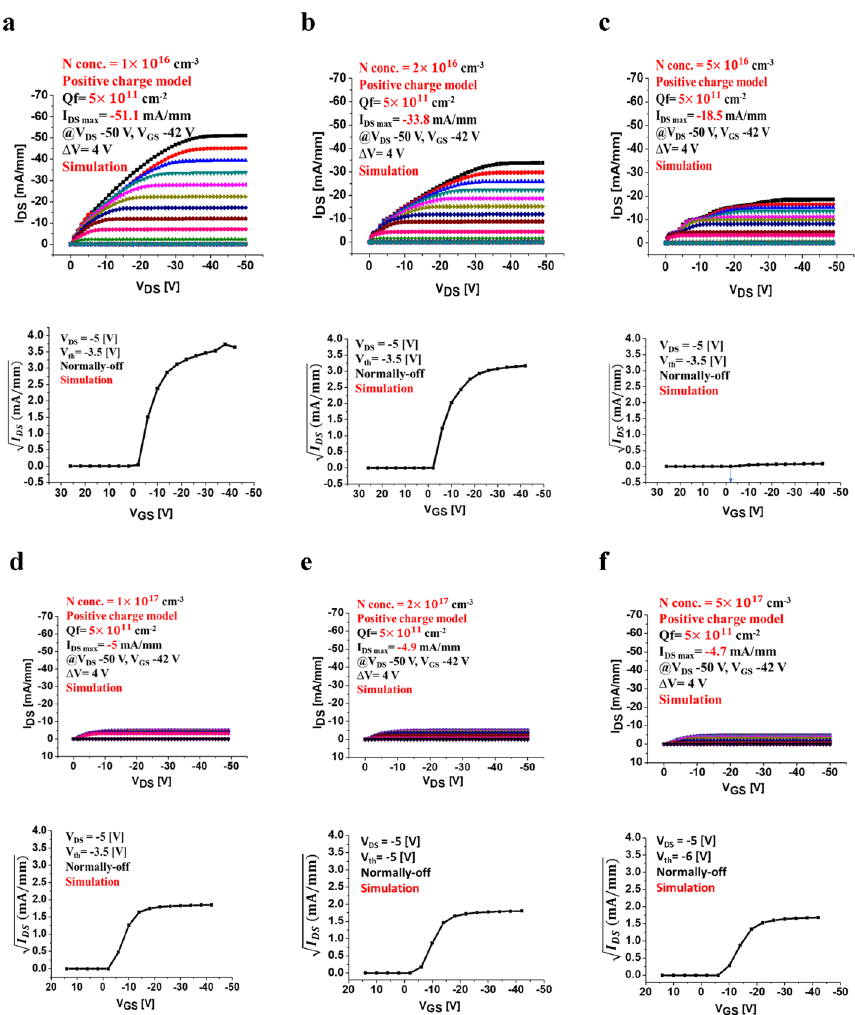
Figure 3. The theoretical modeling and output characteristics of 2DHG diamond MOSFET positive surface charge sheet model (simulation) of 5 × 10 11 cm -2 with a boron doping concentration of 4 × 10 15 cm -3 and various nitrogen doping layer at the room temperature. (a) The maximum drain current density is simulated at I DS Max = − 52 mA/mm with nitrogen concentration of 1 × 10 16 cm -3 and the V th is at − 3 eV. (b) I DS Max = − 33 mA/ mm with nitrogen concentration of 2 × 10 16 cm -3 and the V th is at − 3 eV. (c) I DS Max = − 19 mA/mm with nitrogen concentration of 5 × 10 16 cm -3 and the V th is at − 3 eV. (d) I DS Max = − 5 mA/mm with nitrogen concentration of 1 × 10 17 cm -3 and the V th is at − 3 eV. (e) I DS Max = − 5 mA/mm with nitrogen concentration of 2 × 10 17 cm -3 and the V th is at − 6 eV . (f) I DS Max = − 2 mA/mm with nitrogen concentration of 5 × 10 17 cm -3 and the V th is at − 6